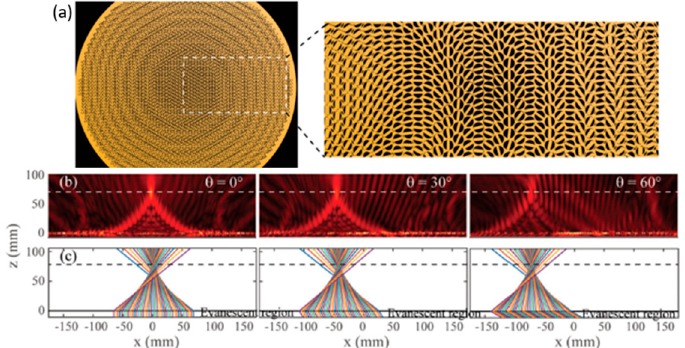
Figure 3. Performance of the wide-angle flat lens. ( a ) Perspective and zoom view of the wide-angle flat lens. ( b ) Simulated light intensity distributed on the 𝑥𝑜𝑧 plane at 19 GHz electric field distributions. ( c ) Ray trajectories of 19 GHz before and after propagating through the flat lens. Left, middle, and right panels of ( b ) and ( c ), respectively, represent the cases of ∅ = 0 ° , 30 ° , 60 ° . (Reproduced from [28] with permission.)